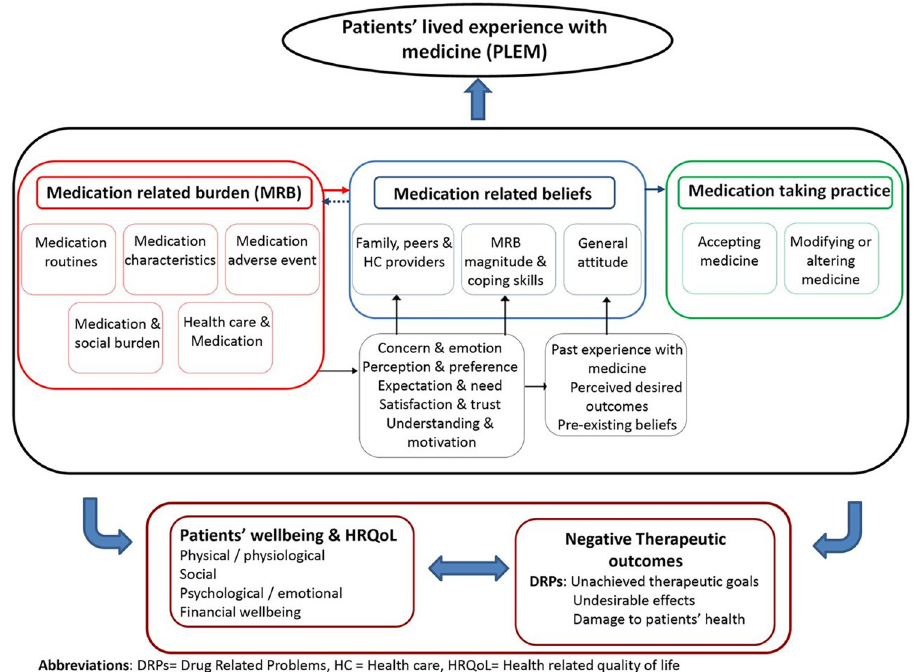
Fig 1. Conceptual framework on patients lived experience with medication [17]. Abbreviations: DRPs = Drug Related Problems, HC = Health care, HRQoL = Health related quality of life.